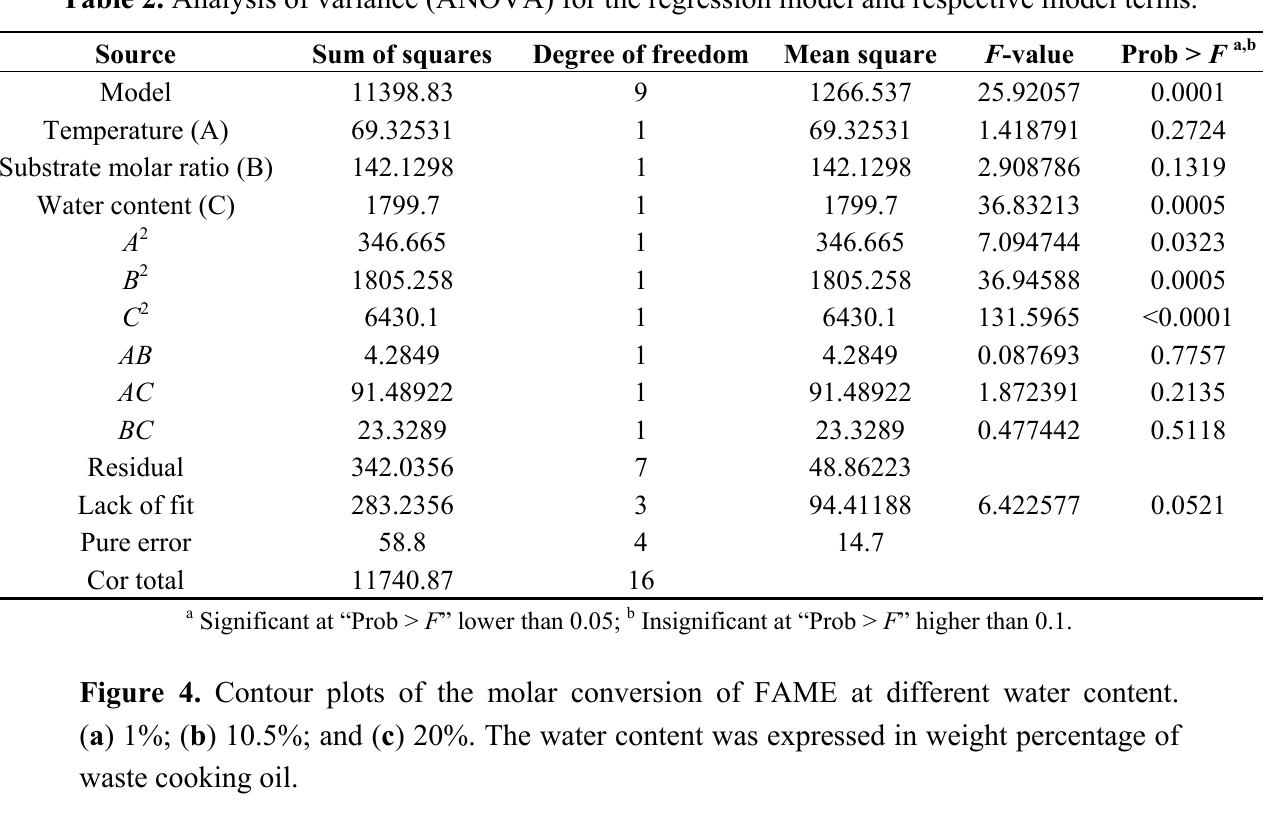
Table 2. Analysis of variance (ANOVA) for the regression model and respective model terms.